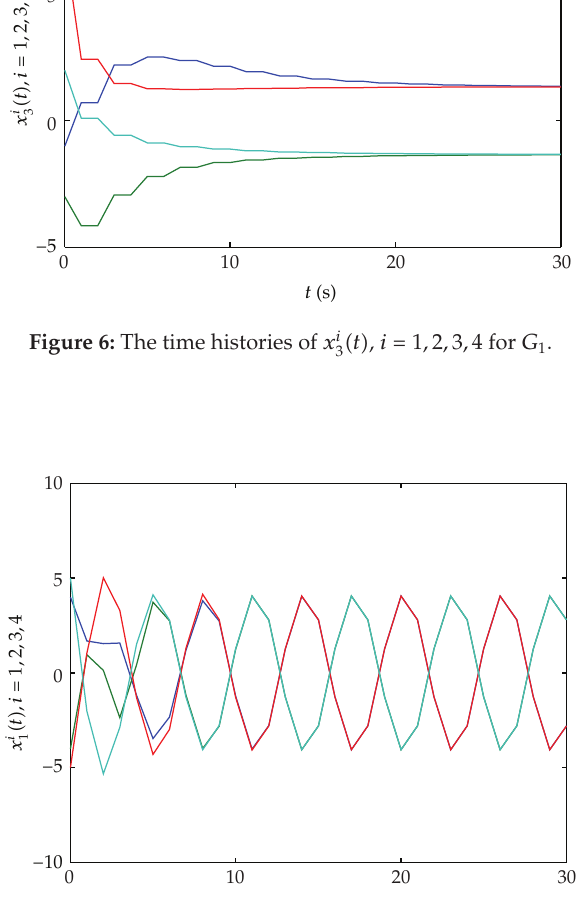
Figure 7: The time histories of x i